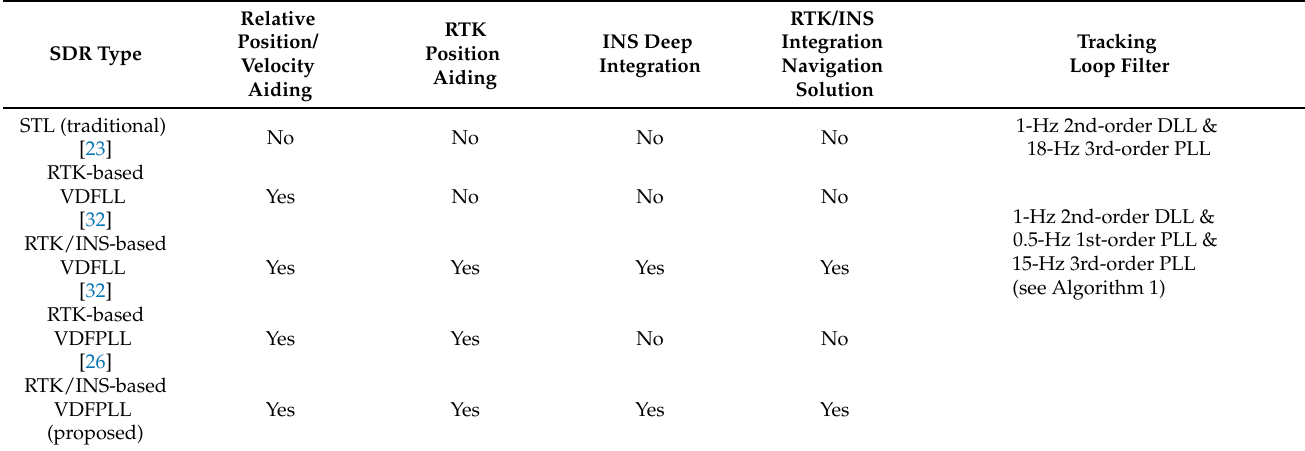
Table 1. Parameter settings of the SDR regarding the real-world experimental